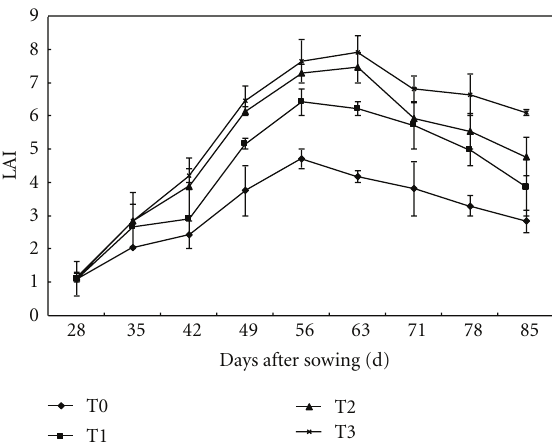
Figure 2: The dynamic variation of LAI in 2002 at Yucheng. Vertical bars are standard errors.